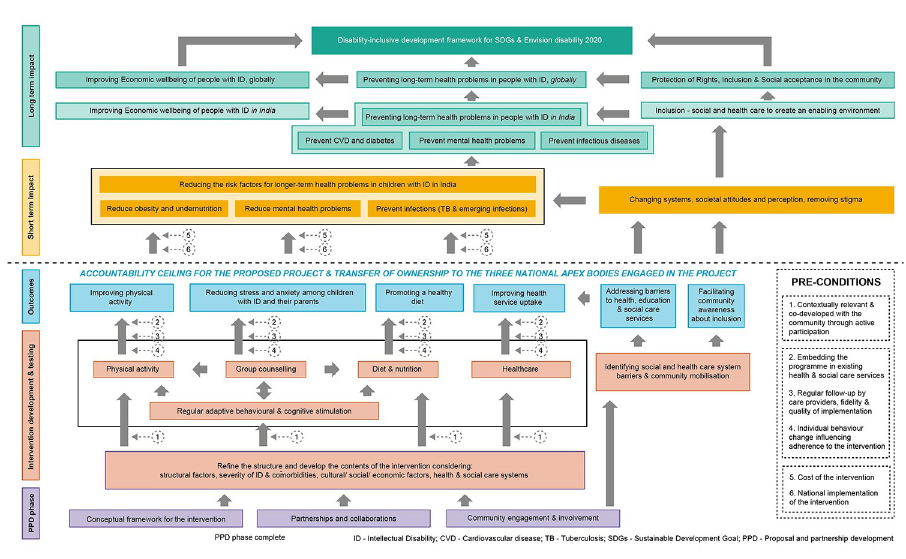
Fig 2. Theory of change